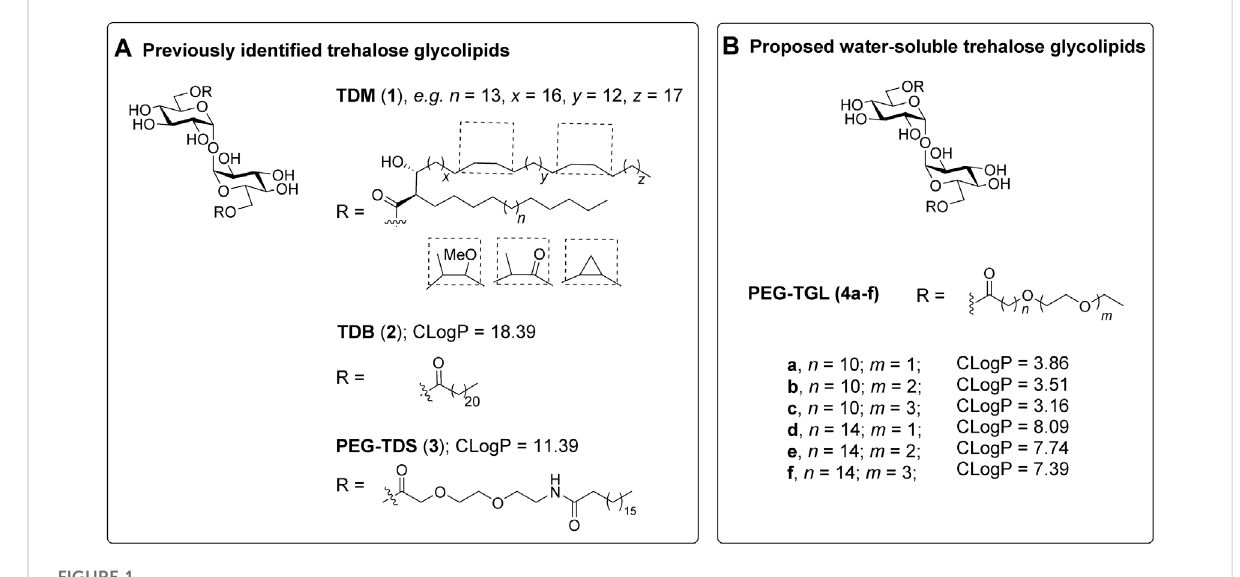
FIGURE 1 Trehalose glycolipids as Mincle-adjuvants. (A) . The previously reported trehalose glycolipids TDM ( 1 ) (Ishikawa et al., 2009) and TDB ( 2 ) (Schoenen et al., 2010) exhibit good Mincle-mediated adjuvanticity, however water-soluble adduct, PEG-TDS ( 3 ) (Huber et al., 2016) exhibits only modest adjuvanticity, which was attributed to poor mMincle binding. (B) We proposed that PEGylated trehalose glycolipids 4a-f would retain good Mincle binding due to the positioning of the PEG groups at the terminus of the lipid. The calculated LogP values provide an indication of water